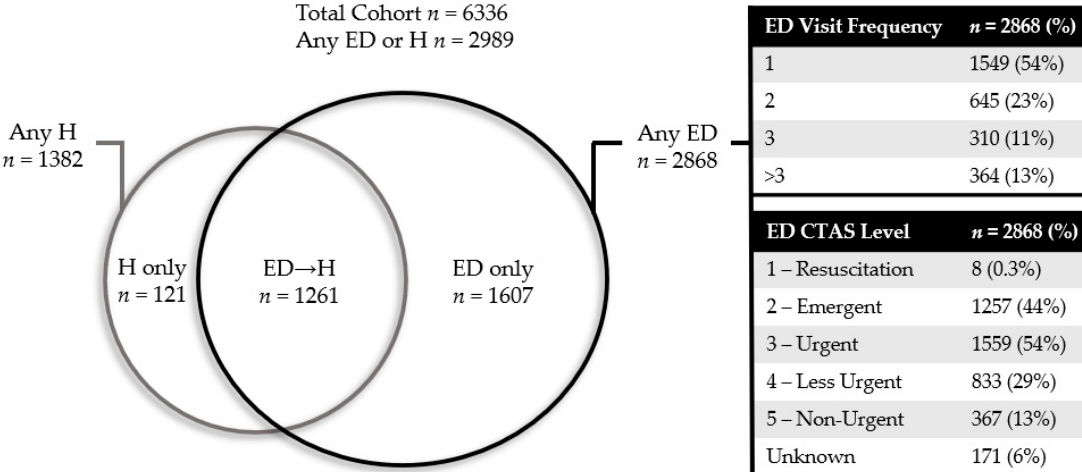
Figure 1. Distribution of acute care utilization in our cohort. Patients with any ED use were further categorized by visit frequency and Canadian Triage and Acuity Scale (CTAS). As patients may have multiple visits, the total percentage for CTAS exceeds 100%.